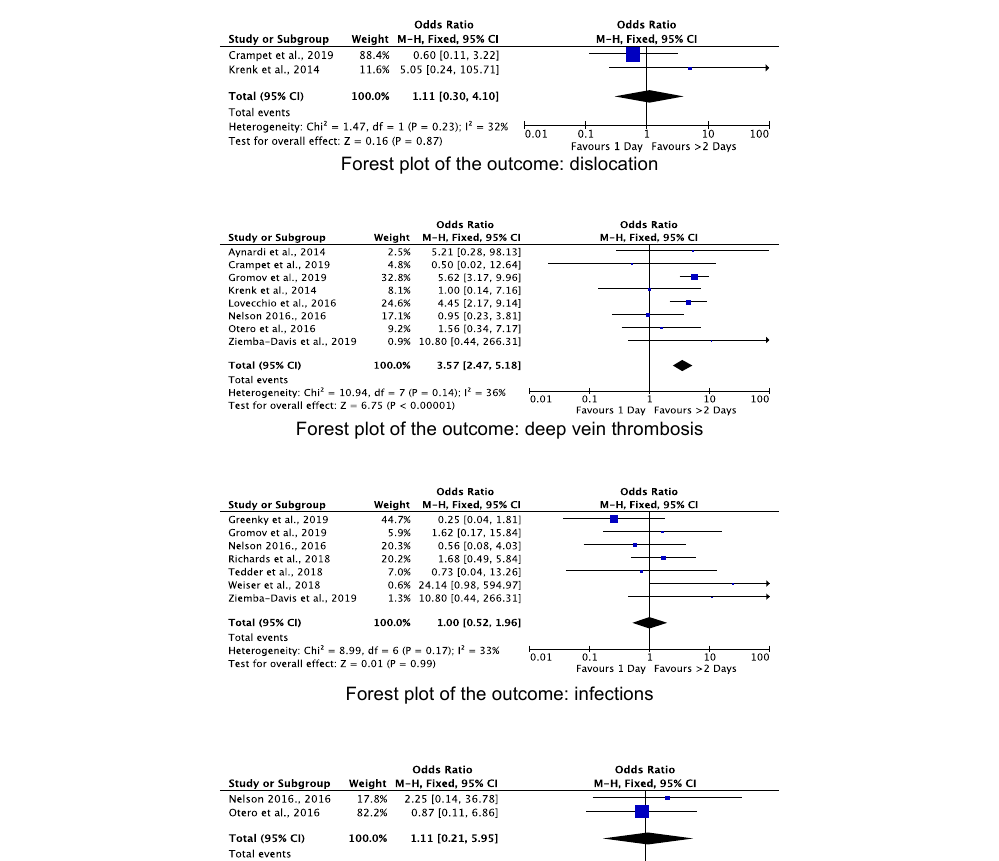
Forest plot of the outcome: mortality